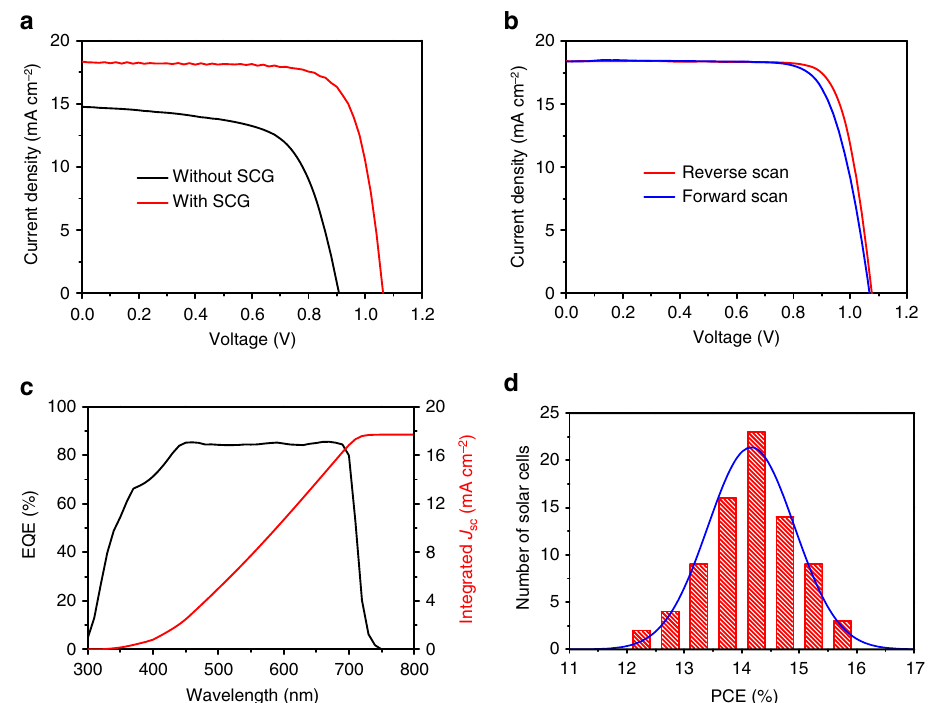
Fig. 3 Device performance of CsPbI 3 -based solar cells. a J – V curves of the devices using CsPbI 3 as the absorber layer, while the CsPbI 3 without and with solvent-controlled growth (SCG), the SCG time is 50 min. b The device performance under forward scan (0 to 1.2 V) and reverse scan (1.2 to 0 V) for the best performance device. c External quantum ef fi ciency (EQE) spectrum of a CsPbI 3 solar cell (black) and the integrated short-circuit current density (red). d Device performance distribution for 80 devices, the curve represents the Gaussian function of the